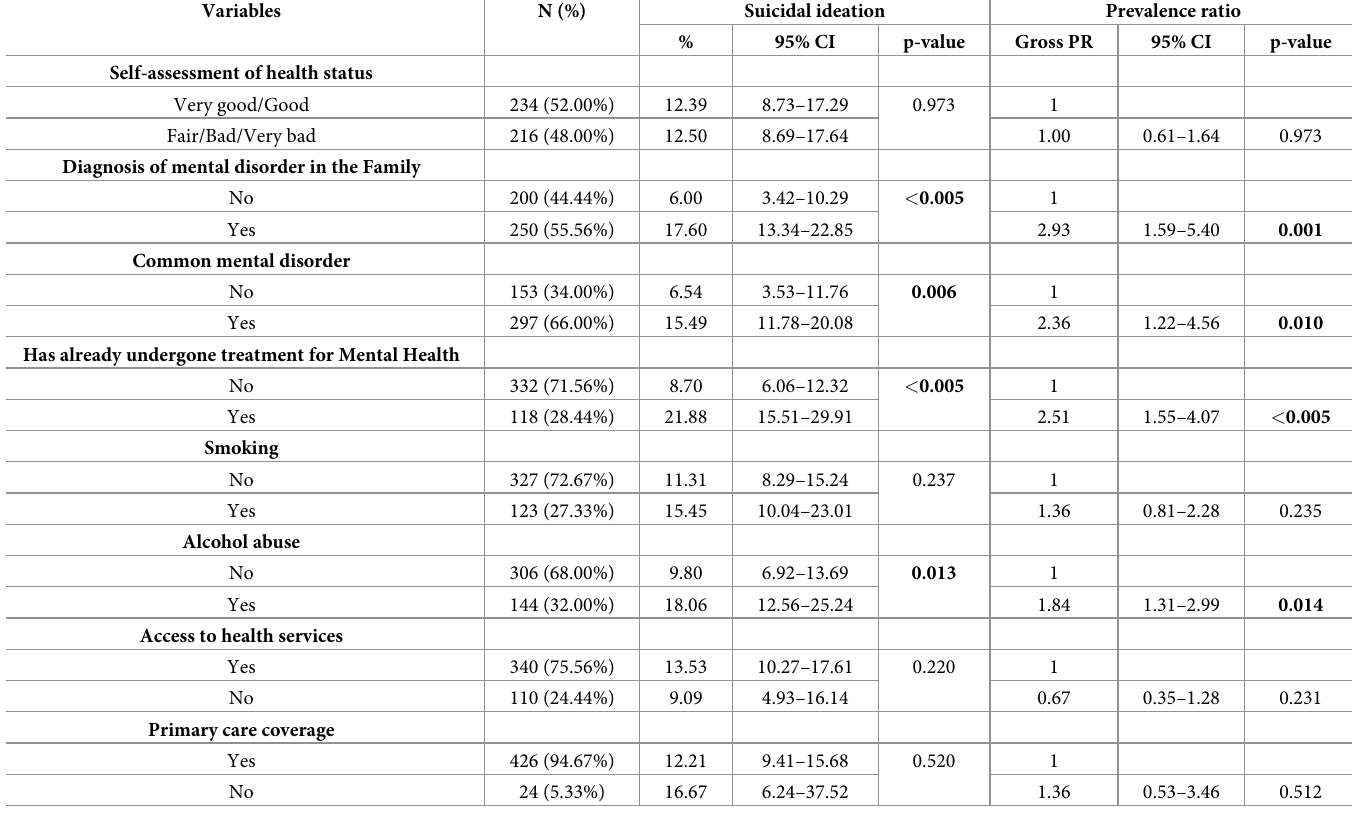
Table 2. Descriptive and bivariate analysis of suicidal ideation and its association with variables of health aspects among farmers in the city of Caico´-RN.